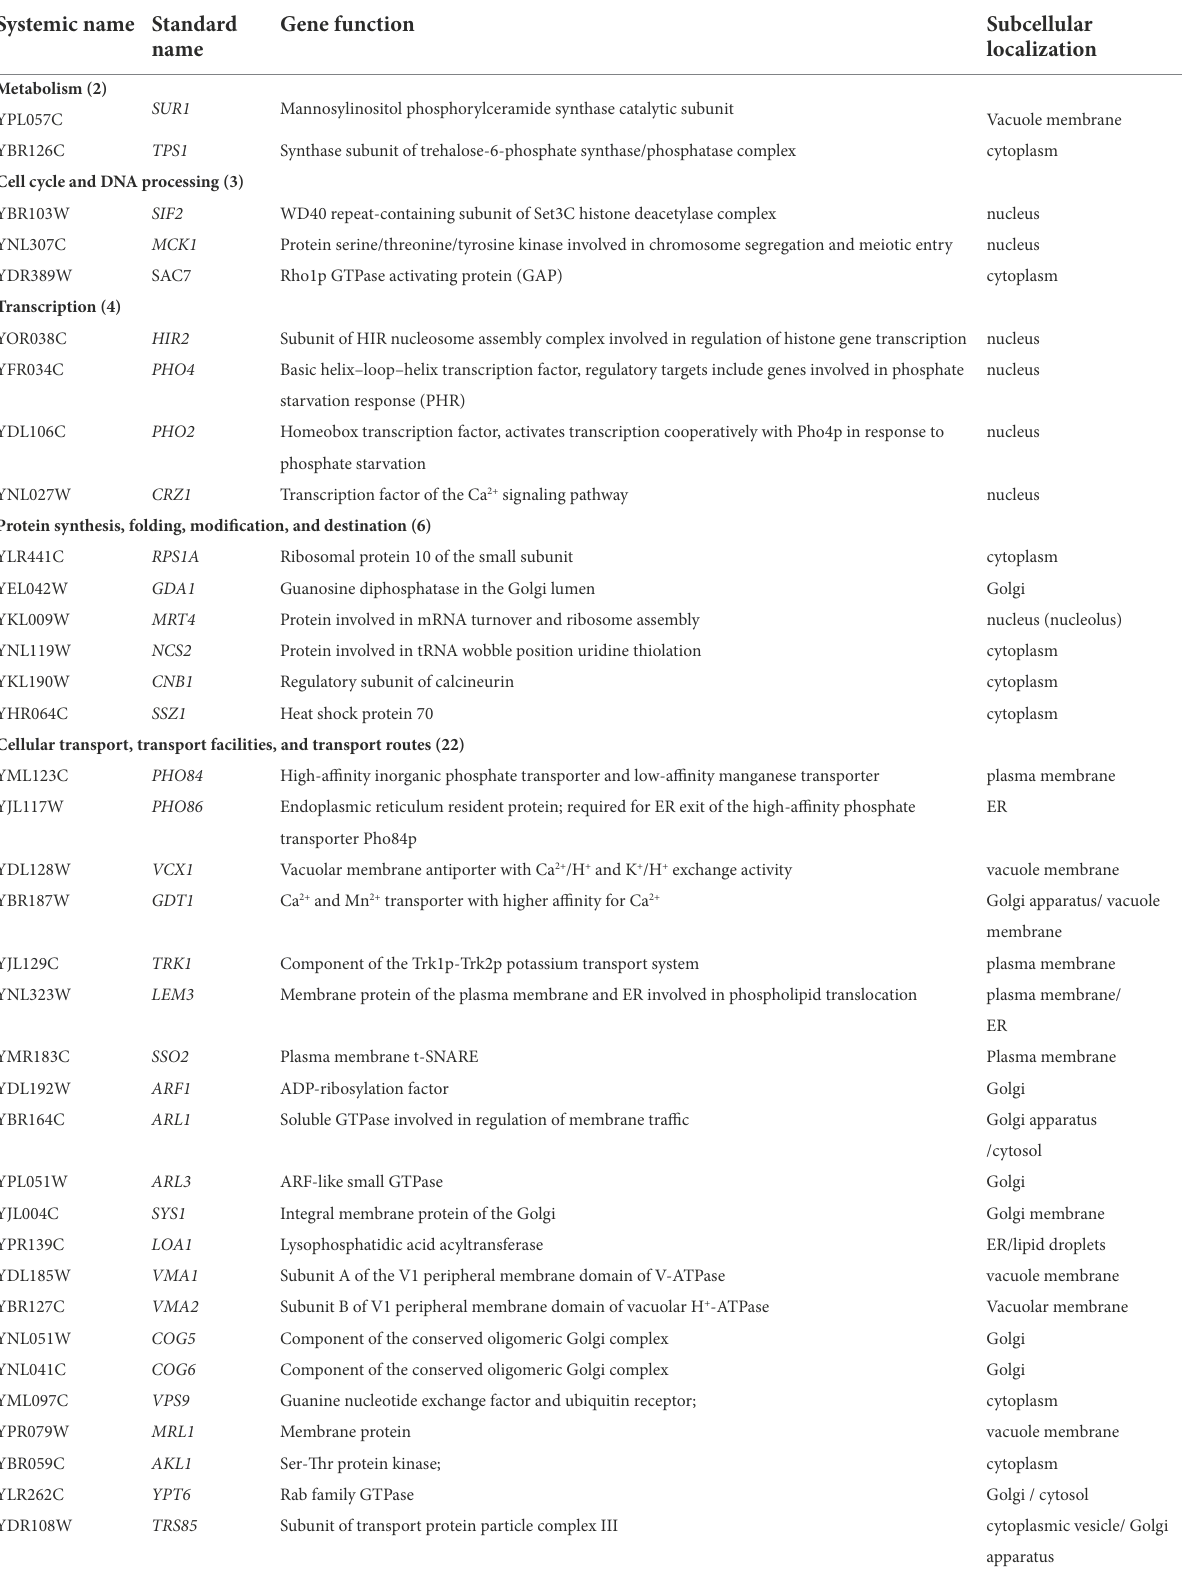
TABLE 1 Localization and function of genes related to Gd-sensitive deletion